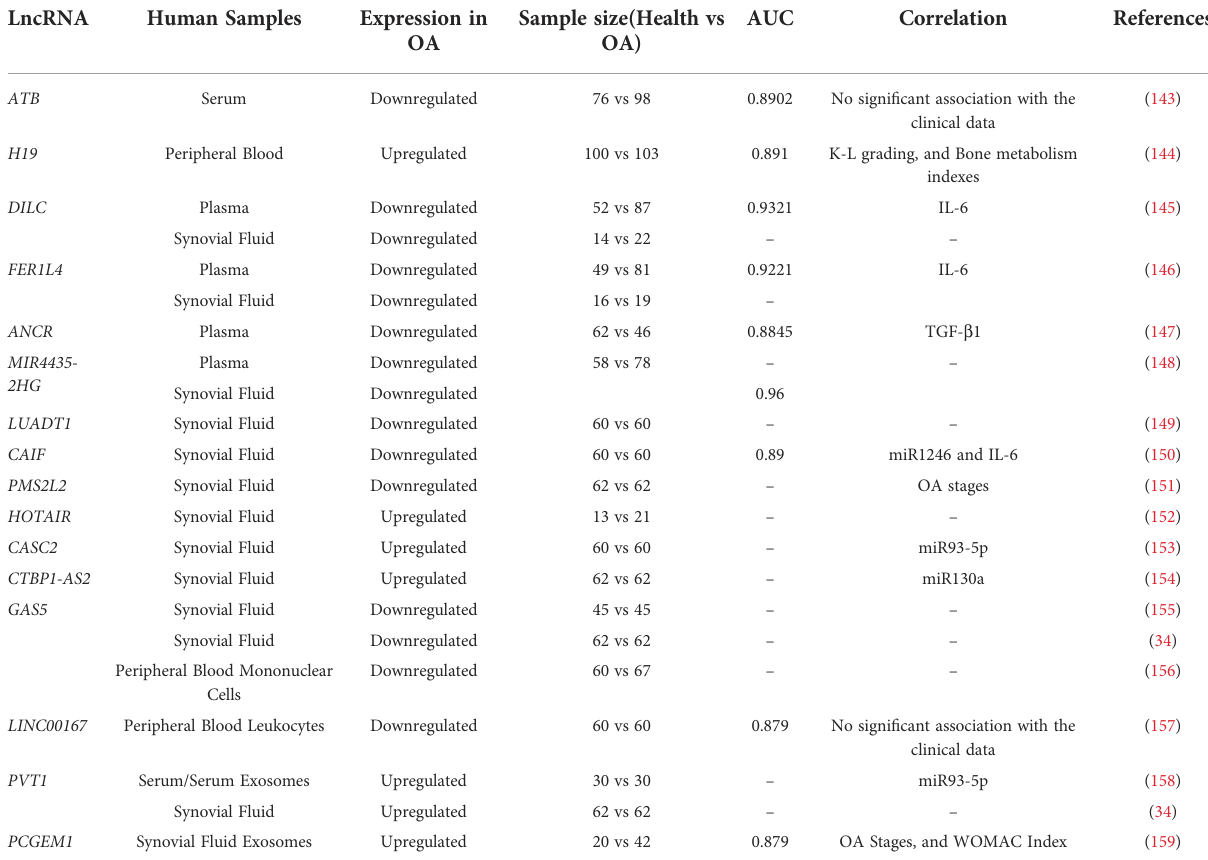
TABLE 2 LncRNAs as biomarkers for OA